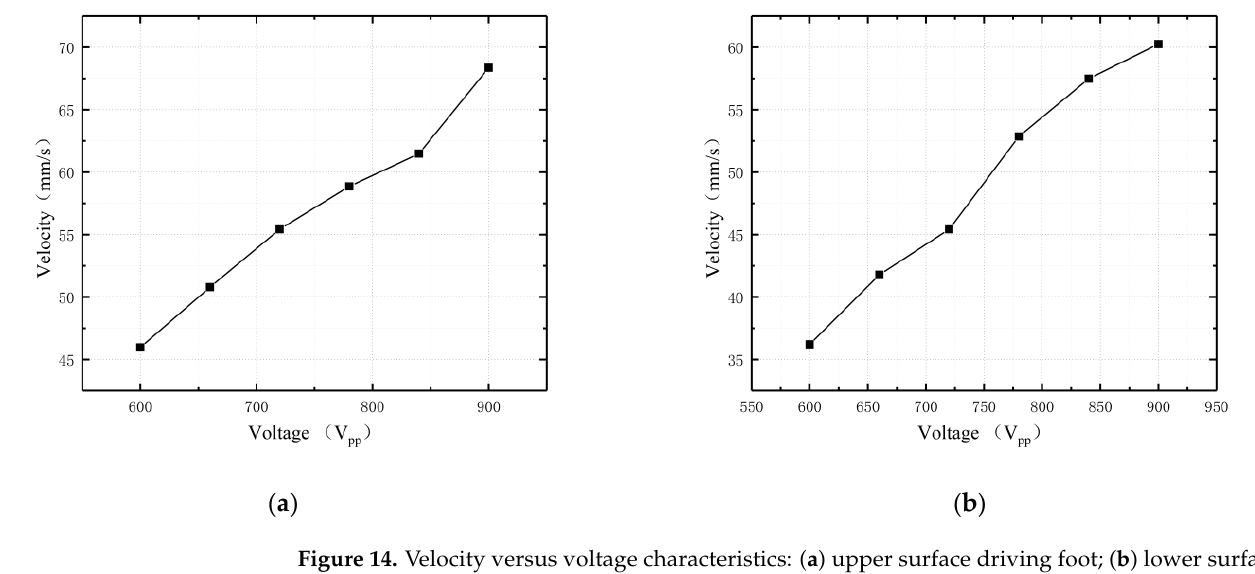
Figure 14. Velocity versus voltage characteristics: ( a ) upper surface driving foot; ( b ) lower surface driving foot.